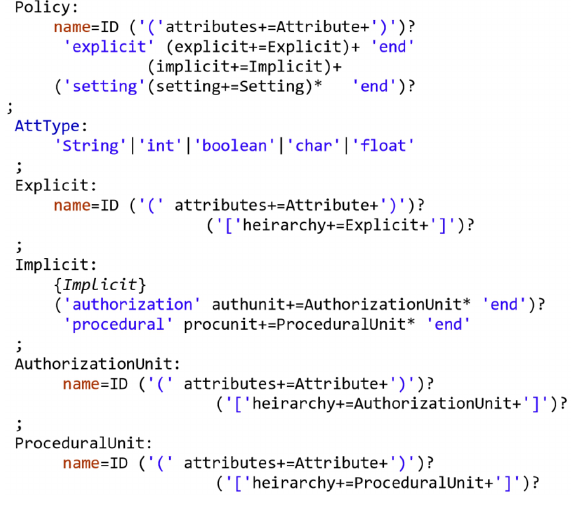
Figure 18. Sample of DSL of HEAD metamodel